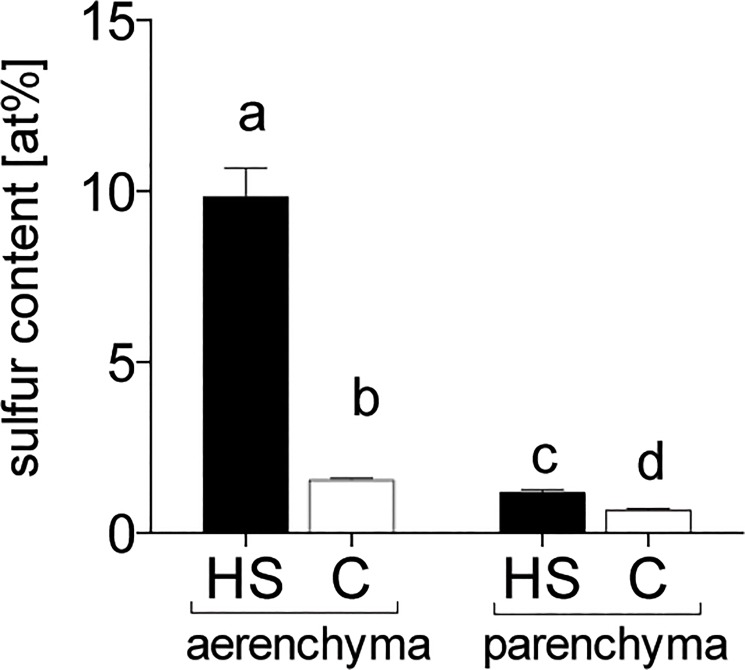
Sulfur content in atomic-percent [at%] by SEM-EDX in Zostera marina roots exposed to sulfide intrusion.Letters indicate significant differences (Dunn's test p < 0.05); n = 48. HS = high sulfide; C = control.